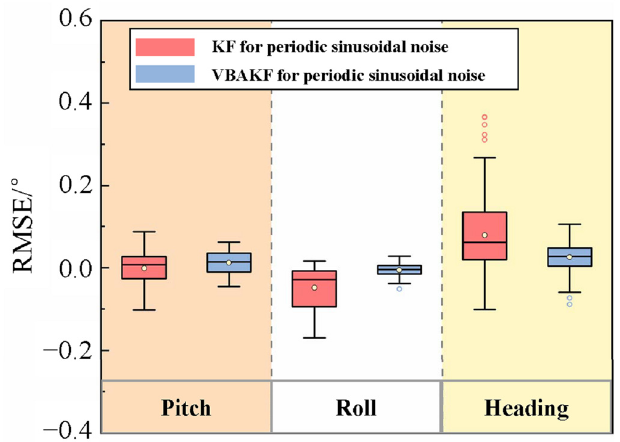
Figure 6. Filtering error box plot when the measured noise covariance is a random quantity with periodic sinusoidal characteristics.